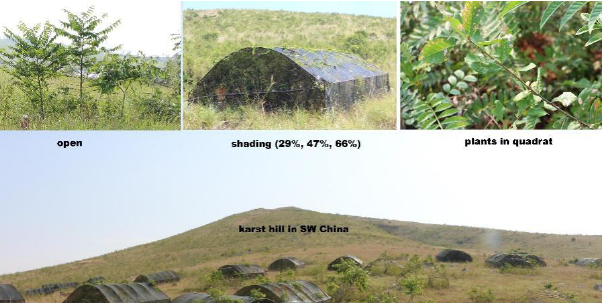
Figure 1. Field restoration plot and experimental design in the karst hill, SW China. Dark rooms covered with different shading nets provided different shading gradients. Seedlings were germinated from the same topsoil that was translocated from the natural forest in local areas in shading rooms and open quadrats.